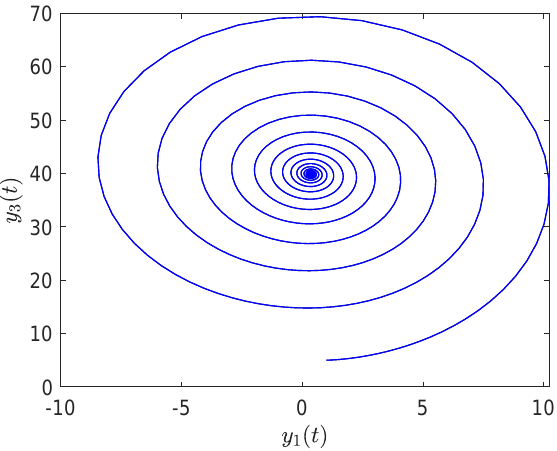
Figure 31. Phase portraits of y 1 and y 3 .